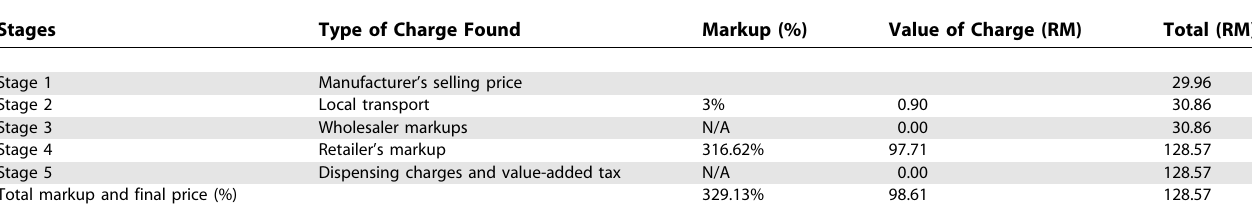
Table 6. Dispensing Doctors’ Sector Component Costs for Generic Omeprazole 20 mg